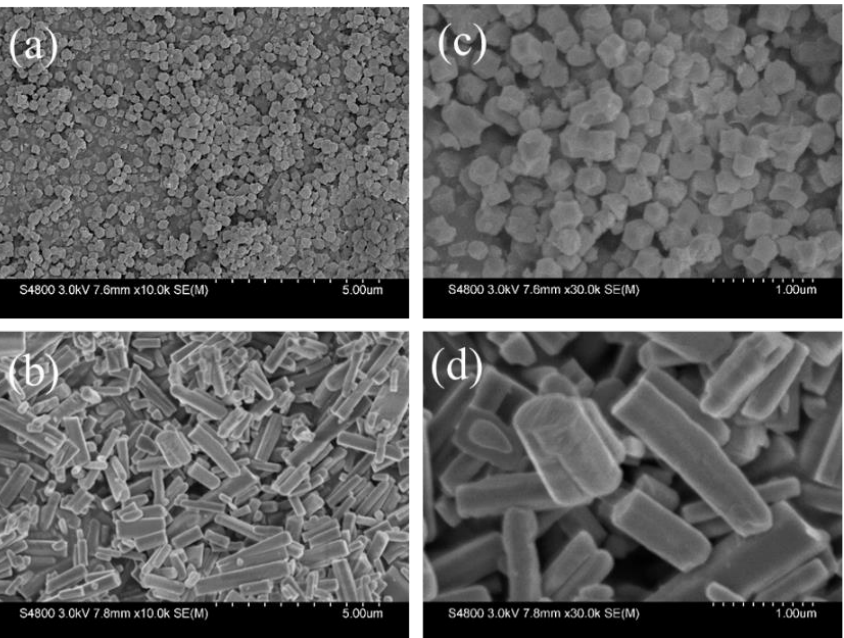
Molecules 2022 , 26 , x FOR PEER REVIEW Figure 2. SEM images of the ZIF-8 ( a ) and ZnBTC ( b ); enlarged images of ZIF-8 ( c ) and ZnBTC ( d ).